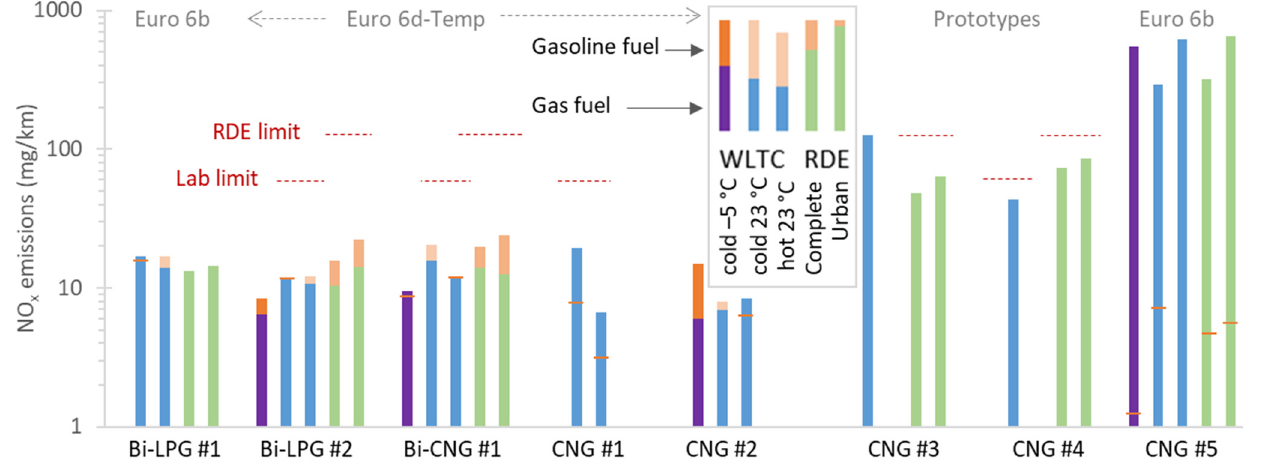
Figure 2. NO x emissions. Dotted lines give the applicable Euro 6 emission limits in the laboratory (Lab) or on the road (RDE). The short orange lines give the gasoline modality emissions when it is lower than the gaseous modality. The limit of Bi-LPG #1 is 60 mg/km for the NEDC, and of CNG #5 is 82 mg/km for the NEDC.